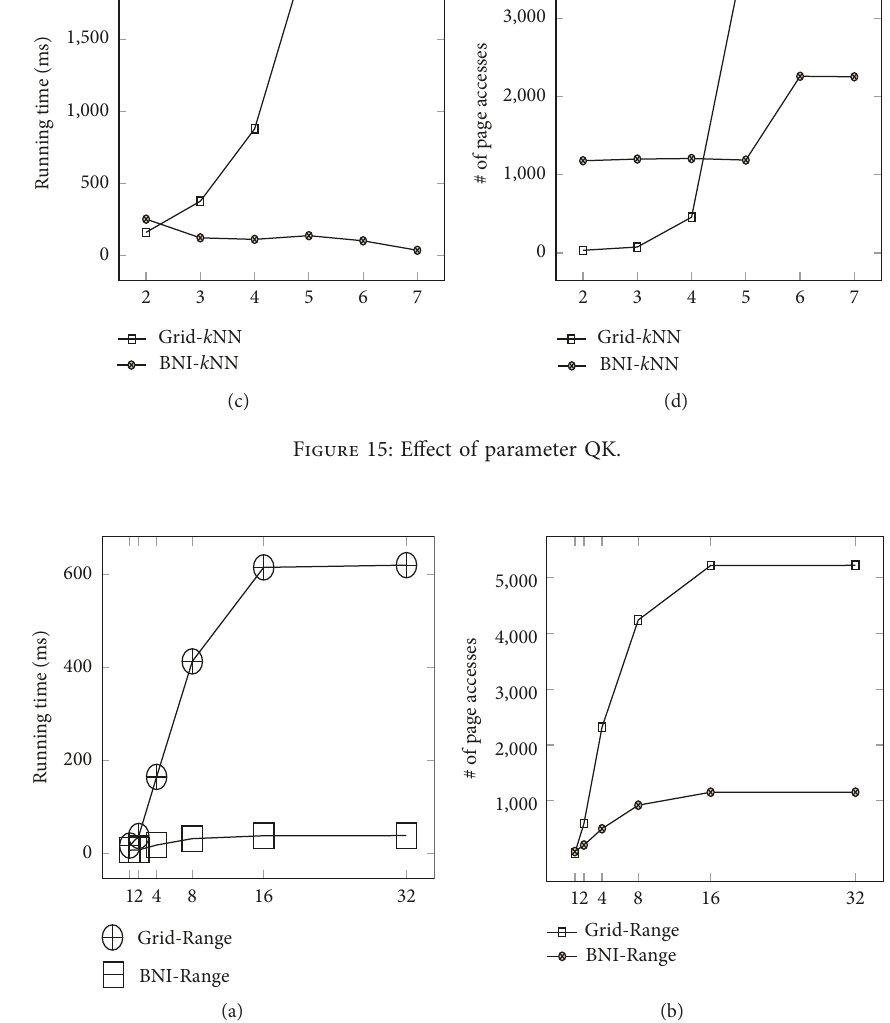
Figure 16: Effect of parameter